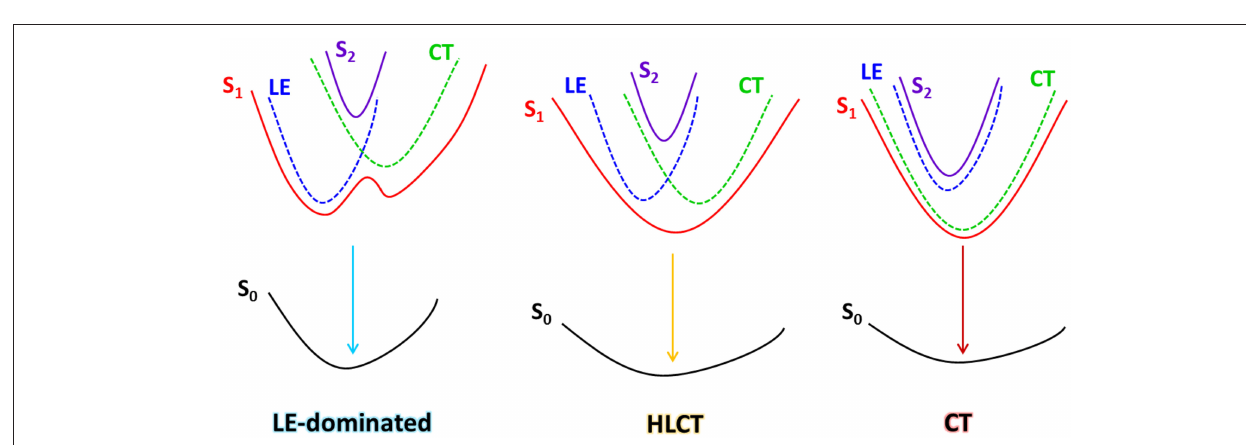
FIGURE 1 | The chemical equations for the synthesis of DPPZ, CZP-DPPZ, TPA-DPPZ, and PXZ-DPPZ.